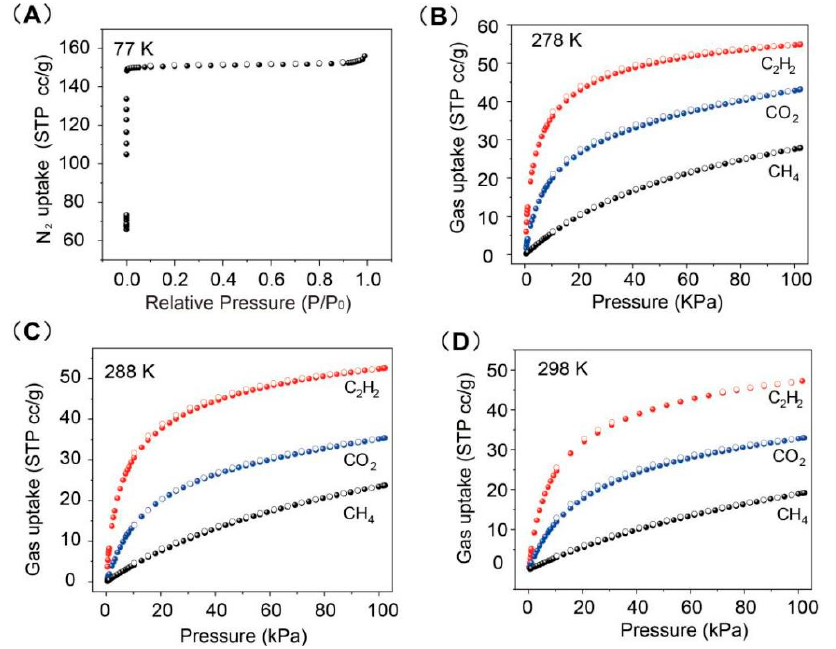
Figure 2. ( A ) N 2 adsorption/desorption isotherms in 1 at 77 K. ( B – D ) C 2 H 2 , CO 2 , and CH 4 adsorp- tion/desorption isotherms in 1 at 278 K, 288 K, and 298 K.